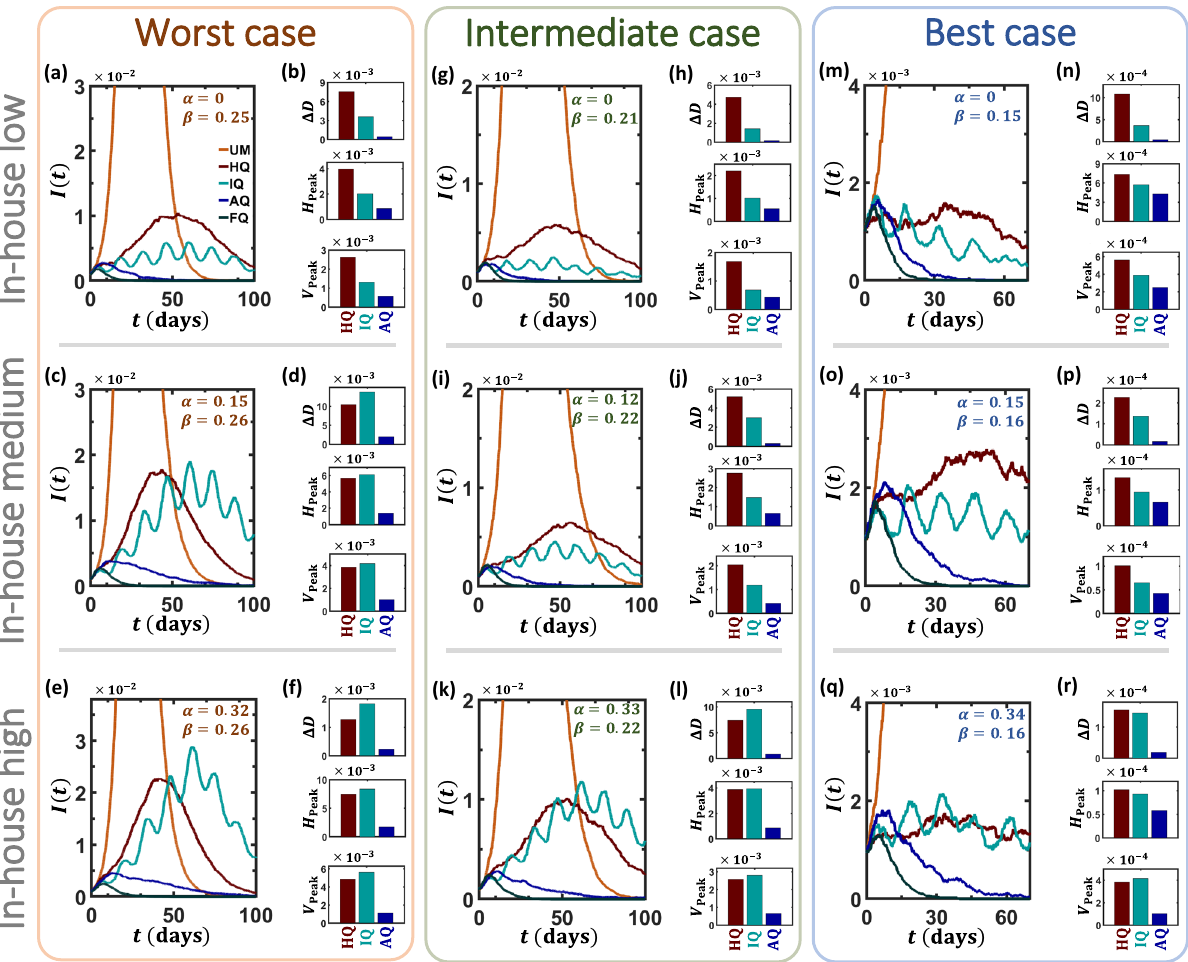
Fig. 4 The impact of alternating quarantine. a The infection I ( t ) vs. t of the unmitigated epidemic (UM, orange), as obtained under β = 0.25 and α = 0. This represents a worst-case scenario, where β is taken from the unmitigated spreading data, i.e., lacking prophylactic practices. At t = t 0 we instigate four competing mitigation strategies: Full quarantine (FQ, gray), Alternating quarantine (AQ, blue), Intermittent quarantines (IQ, turquoise), and Half quarantine (HQ, red). We fi nd that, barring the idealized FQ, AQ provides the most ef fi cient mitigation, outperforming IQ, and HQ. b We used three performance measures to rate mitigation ef fi ciency: Residual mortality Δ D (3), peak hospitalization H Peak (4), and peak ventilation V Peak . In all